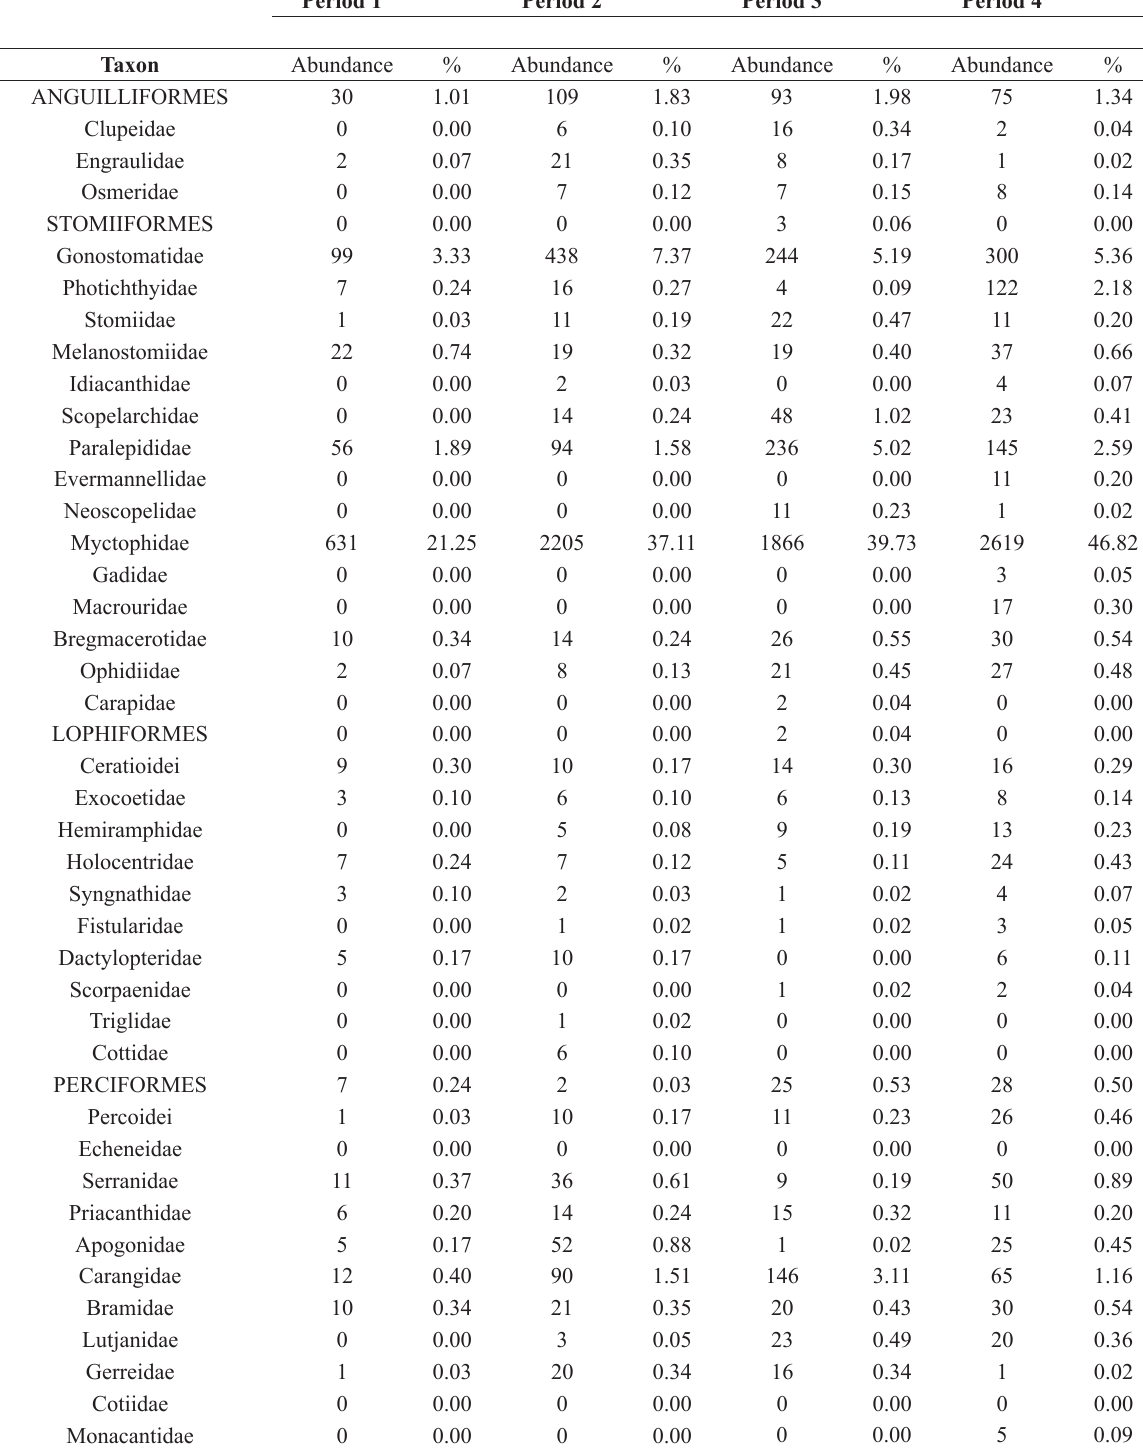
Family groups represented in ichtyoplankton samples collected in the west tropical Atlantic Ocean. Abundance is a sum of larvae from all positive stations and % is a percentage of total